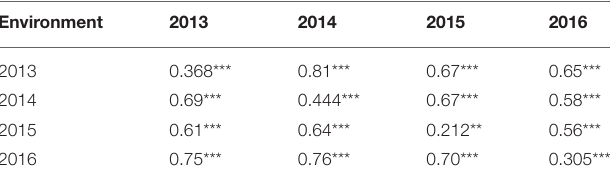
Above diagonal line: correlation for SW between years; Diagonal line: correlation between SW and SL; Below diagonal line: correlation for SL between years ** Significance level at p = 0.01, *** Significance level at p = 0.001.